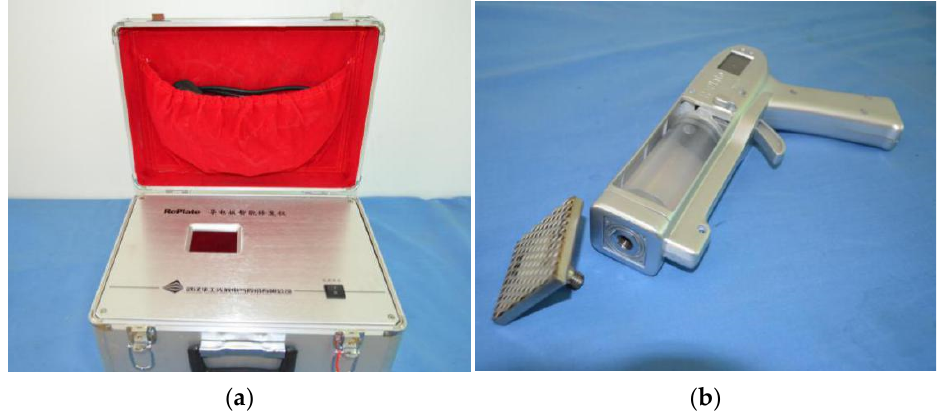
Figure 8. Brush plating main tool. ( a ) Brush plating power supply, ( b ) brush plating pen.